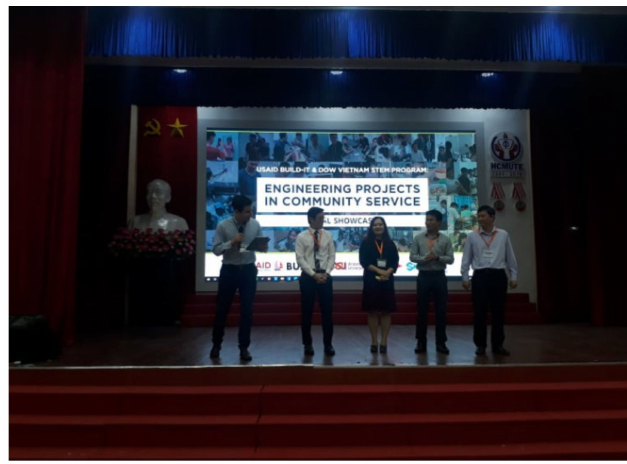
Figure 26. Participants in TechShow.